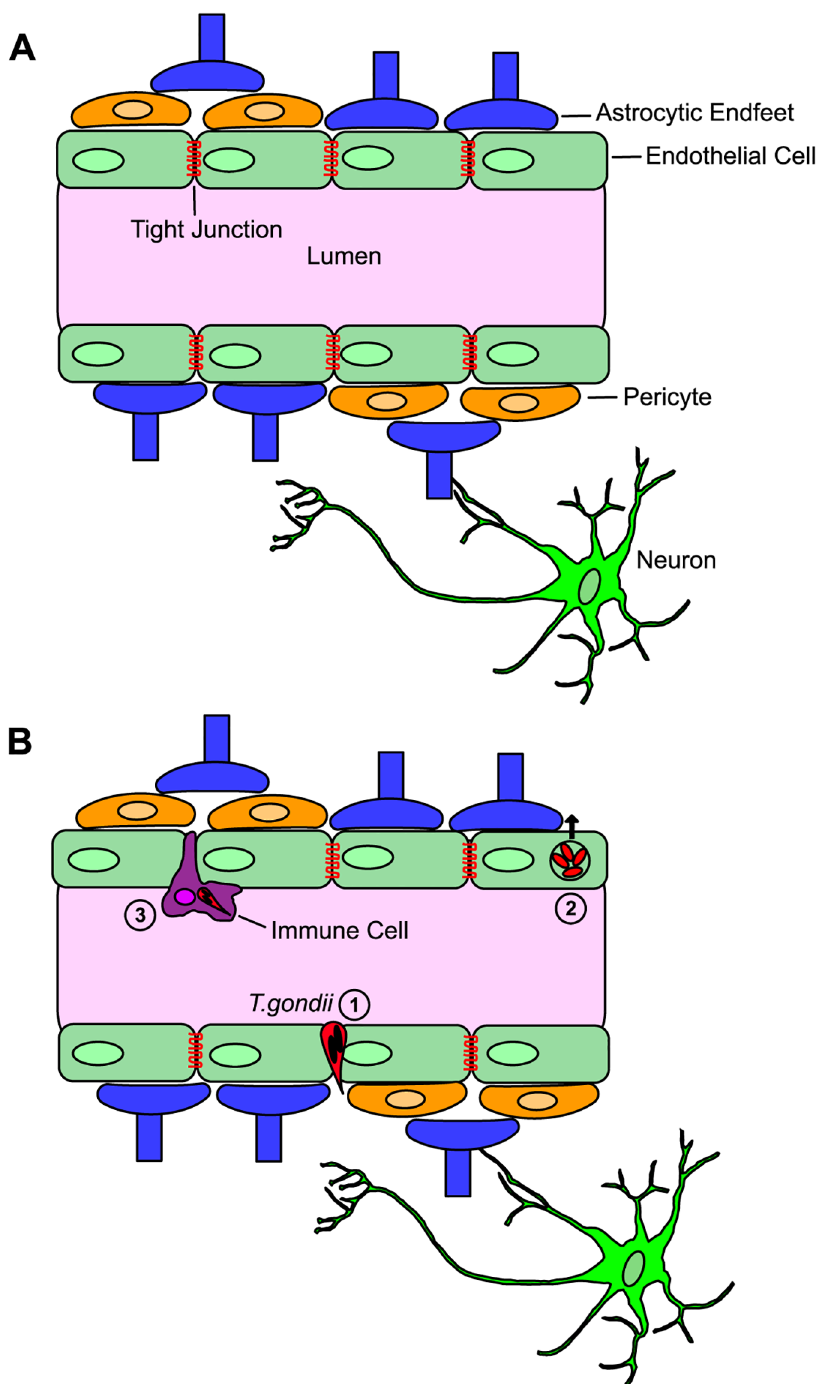
Fig 1. Diagram of the physical and cellular interactions that compose the blood-brain barrier. (A) The blood-brain barrier (BBB) is composed of microvessels surroundedby an endothelial cell layer with tight junctions;pericytes surround the tight junctionsand then astrocytic processes or endfeet provide the final layer. (B) Toxoplasmagondii has been postulatedto have 3 mechanisms for crossing the BBB. (1) Paracellular entry, in which T . gondii migrates directly through the tight junctionsof the endothelial cell layer, (2) transcellular entry, in which free parasitesin the vascular compartment infect endothelialcells, replicate, and then egress out of the basolateralside of endothelialcell (lysing the host cell), (3) the “Trojan horse” method, wherebyan infected immune cell infiltrates the CNS, after which the parasiteegressesout of the immune cell and into the brain